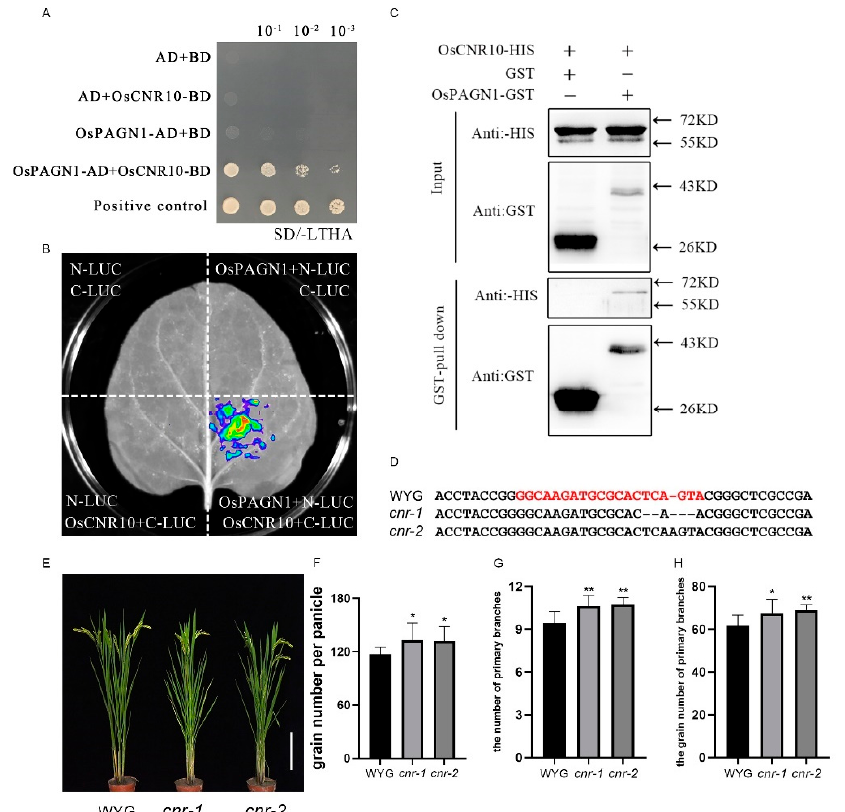
Figure 2. Interaction between OsPAGN1 and OsCNR10. ( A ) Yeast two-hybrid assay of OsPAGN1 and OsCNR10. More specifically, OsCNR10 was fused with the DNA-binding domain (BD) of GAL4, whereas OsPAGN1 was fused with the activation domain (AD) of GAL4. Yeast cells transformed with the recombinant plasmids were grown on the synthetic defined medium lacking Leu, Trp, His, and Ade (SD − LTHA). ( B ) Split-luciferase assay. OsPAGN1 and OsCNR10 were fused with the N-terminal (nLUC) and C-terminal (cLUC) portions of firefly luciferase (LUC), respectively. Different combinations of constructs were inserted into tobacco leaves and then the chemiluminescence was detected after adding the substrate luciferin. ( C ) Pull-down assay. OsPAGN1 and OsCNR10 were fused with the GST and HIS tags, respectively. After a co-incubation with both proteins, the proteins were immunoprecipitated using glutathione resin and analyzed using anti-HIS and anti-GST antibodies. Phenotypes of the OsCNR10 knockout lines. ( D ) Target site in the OsCNR10 sequence in the OsCNR10 knockout lines cnr-1 and cnr-2 ( E ) Plant architecture of the wild-type (Wuyugeng) and OsCNR10 knockout lines. ( F – H ) Grain number per panicle, number of primary branches, and grain number for the primary branches of the wild-type and OsPAGN1 knockout lines. The data are the mean ± SEM. * p < 0.05, ** p < 0.01. (Student’s t test).